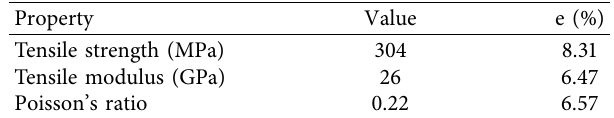
Figure 1: Configuration of slab-rib integrated bridge deck systems: (a) cross section of sandwich decks without webs, (b) cross section of sandwich decks with vertical webs, (c) cross section of sandwich decks with horizontal webs, (d) cross section of sandwich decks with vertical and horizontal webs, and (e) 3D view of decks with cross beams (1: foam core; 2: FRP skin; 3: vertical webs; 4: horizontal webs). Table 1: Tensile properties of